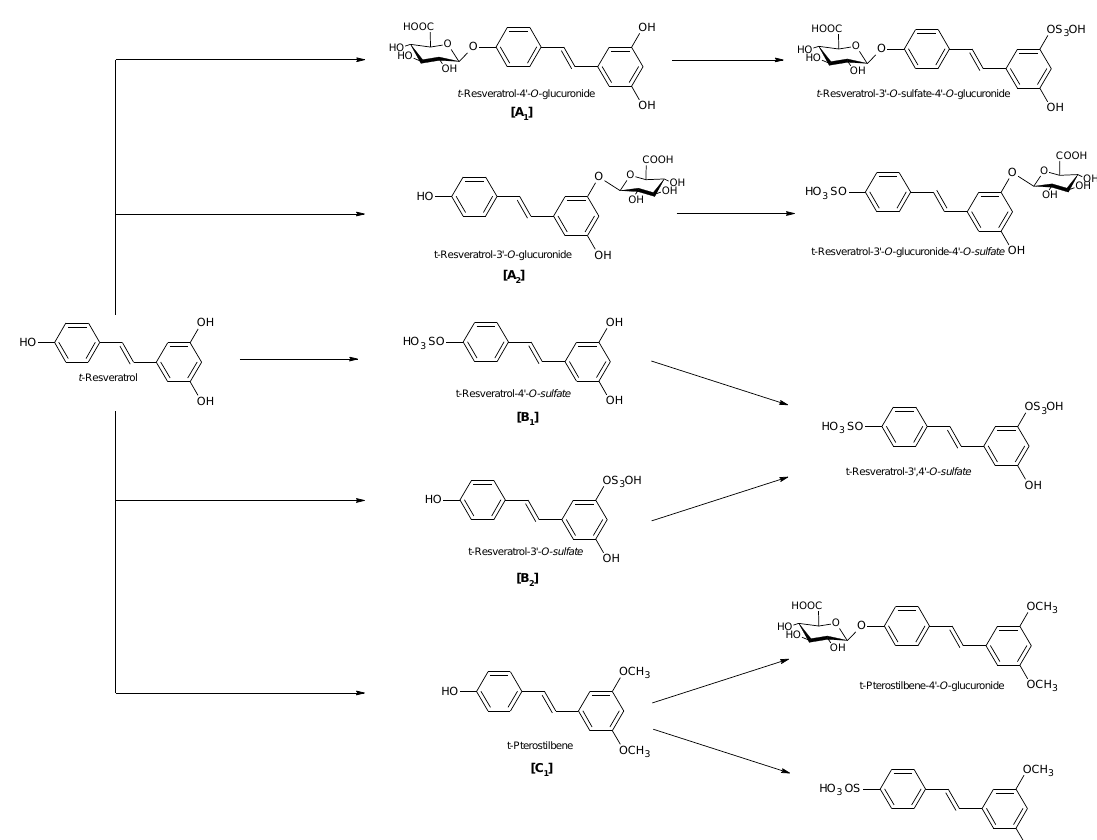
Figure 2. Phase II metabolism of trans -resveratrol. [A 1 ]: 4′-glucuronic conjugation; [A 2 ]: 3-glucuronic conjugation; [B 1 ]: 4′-sulfate conjugation; [B 2 ]: 3-sulfate conjugation; [C 1 ]: 3,5-dimethyl conjugation.